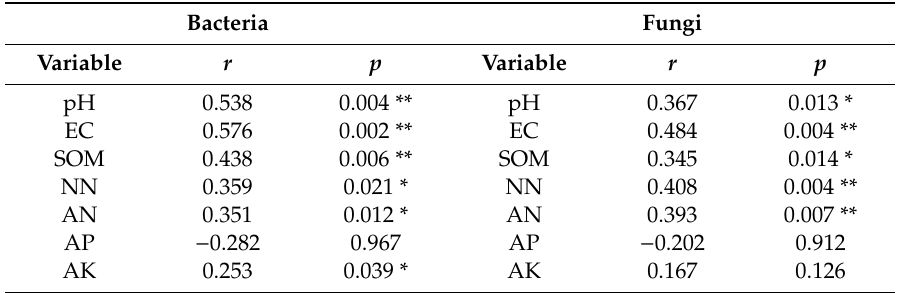
Table 3. Mantel test analysis of microorganisms and soil environment factors at the operational taxonomic unit (out) level.